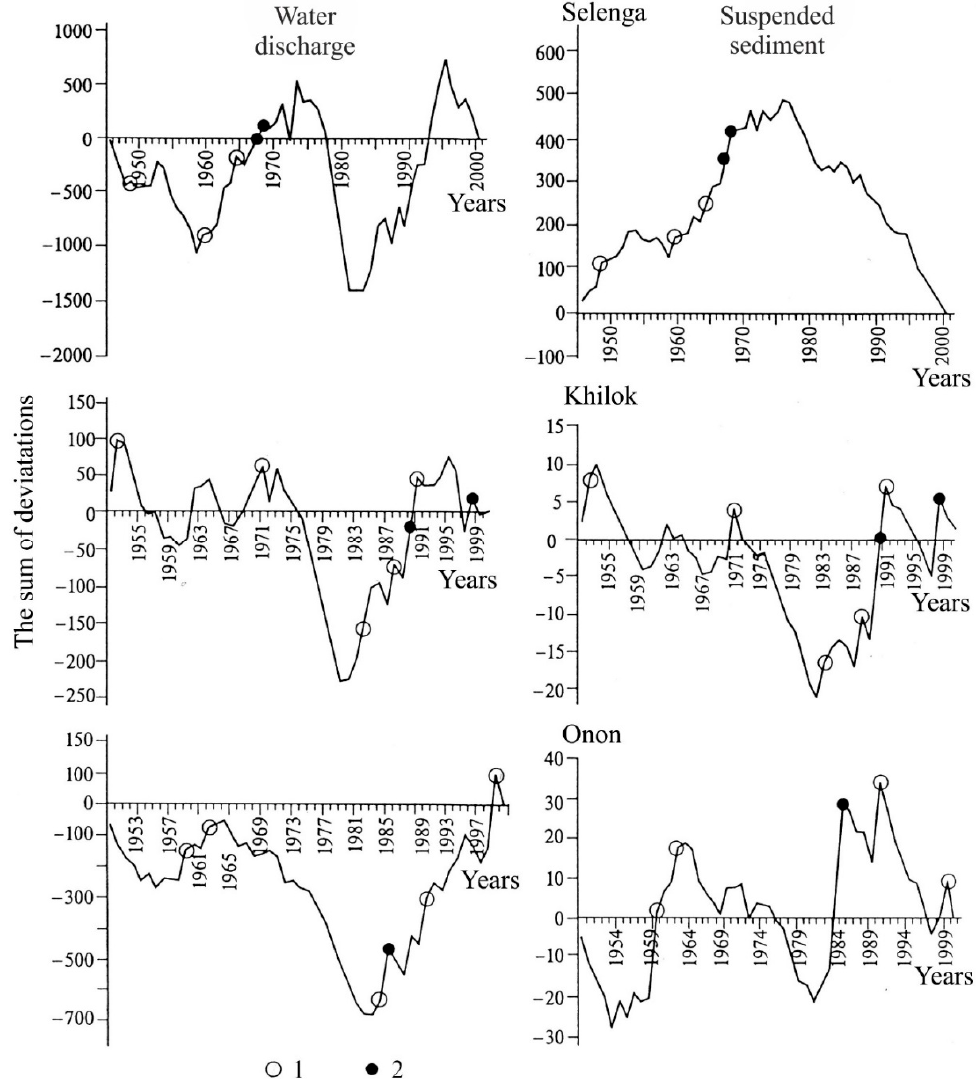
Figure 11. Difference–integral curves of water discharge and suspended sediment of the Transbaikalia rivers (1—extremals of suspended sediment yield, 2—the maxima).